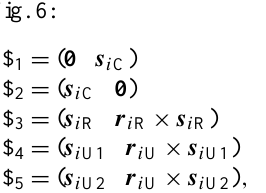
Figure 4. A CAD model of a cylindrical joint.